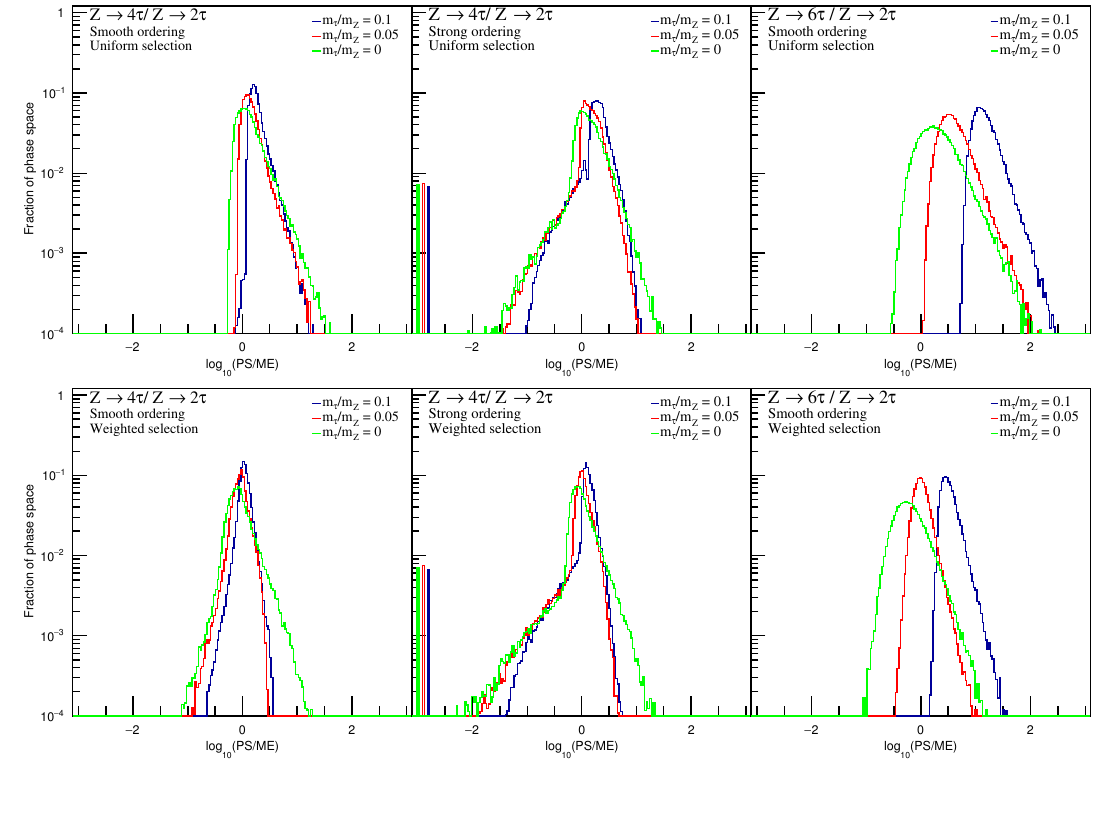
Figure 7 . Comparison of the shower approximation to matrix elements for a combination of emissions and splittings from Z ! 2 (cid:28) . In the top row, the spectator is selected uniformly, while in the bottom row, the selection probability given by eq. (3.9) is